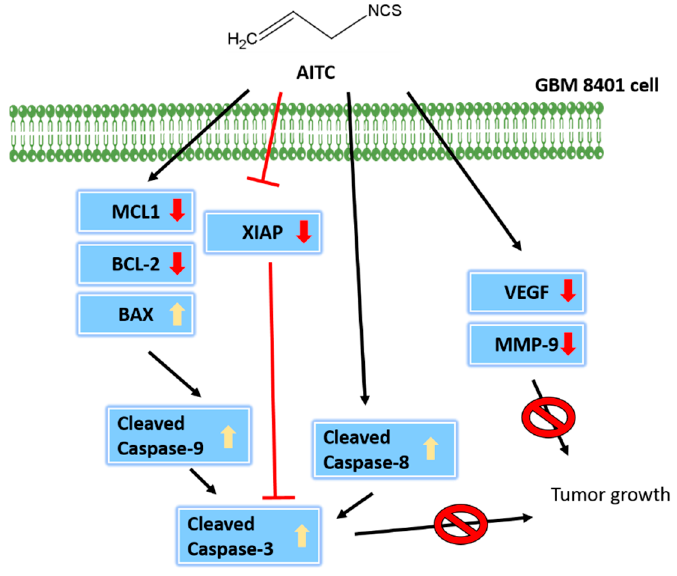
Figure 7. The mechanisms involved in AITC-driven inhibition of tumor growth.